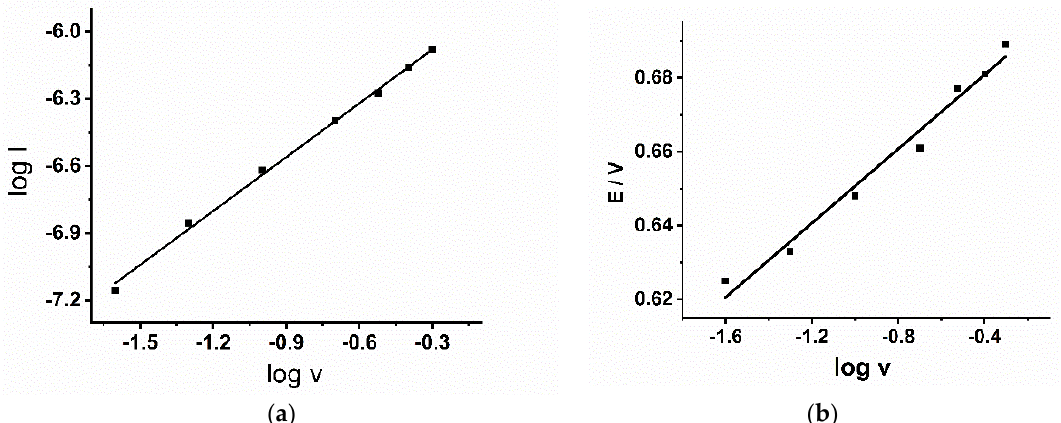
Figure 4. ( a ) Linear dependence of the logarithm of the anodic peak current on the logarithm of the potential scan rate for SNGCE/AuNPs. ( b ) Linear dependence of the peak potential on the logarithm of the potential scan rate for SNGCE/AuNPs.